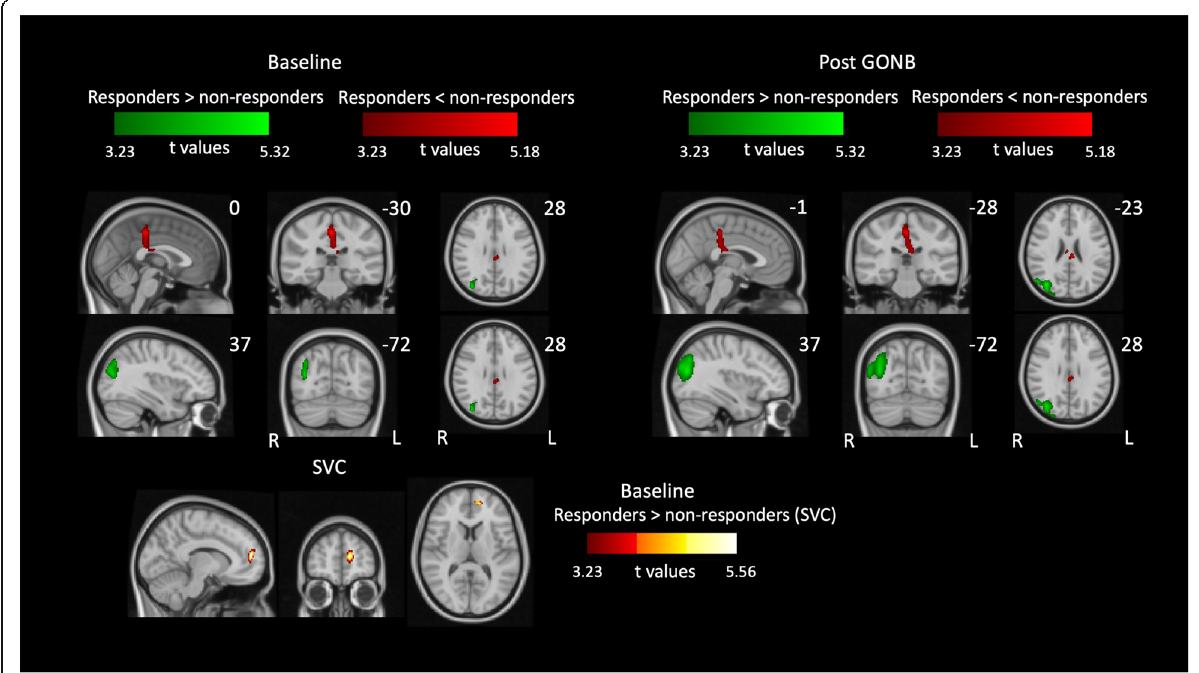
Fig. 3 Differences in rCBF between the responders and the non-responders groups of CH patients at baseline (left panel) and following GONB (right panel). Increased local perfusion in responders (green) is observed in the LOC both prior and after GONB, being extended in the post GONB session. Increased local perfusion in non-responders comprised the PCC and the PMC in both sessions. Lower panel shows increased activation in mPFC for the responders group after performing small volume correction (SVC). Data included four CBF maps per patient and session. All clusters are significant at p < 0.05 (FWE corrected; initial height threshold set to 0.001). GONB = greater occipital nerve block; R = right; L =